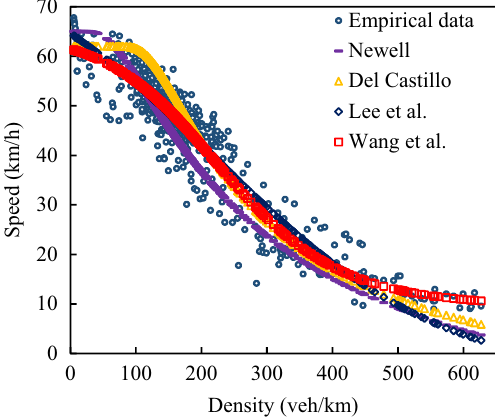
Fig. 6 Geometric fitness of the complex traffic stream